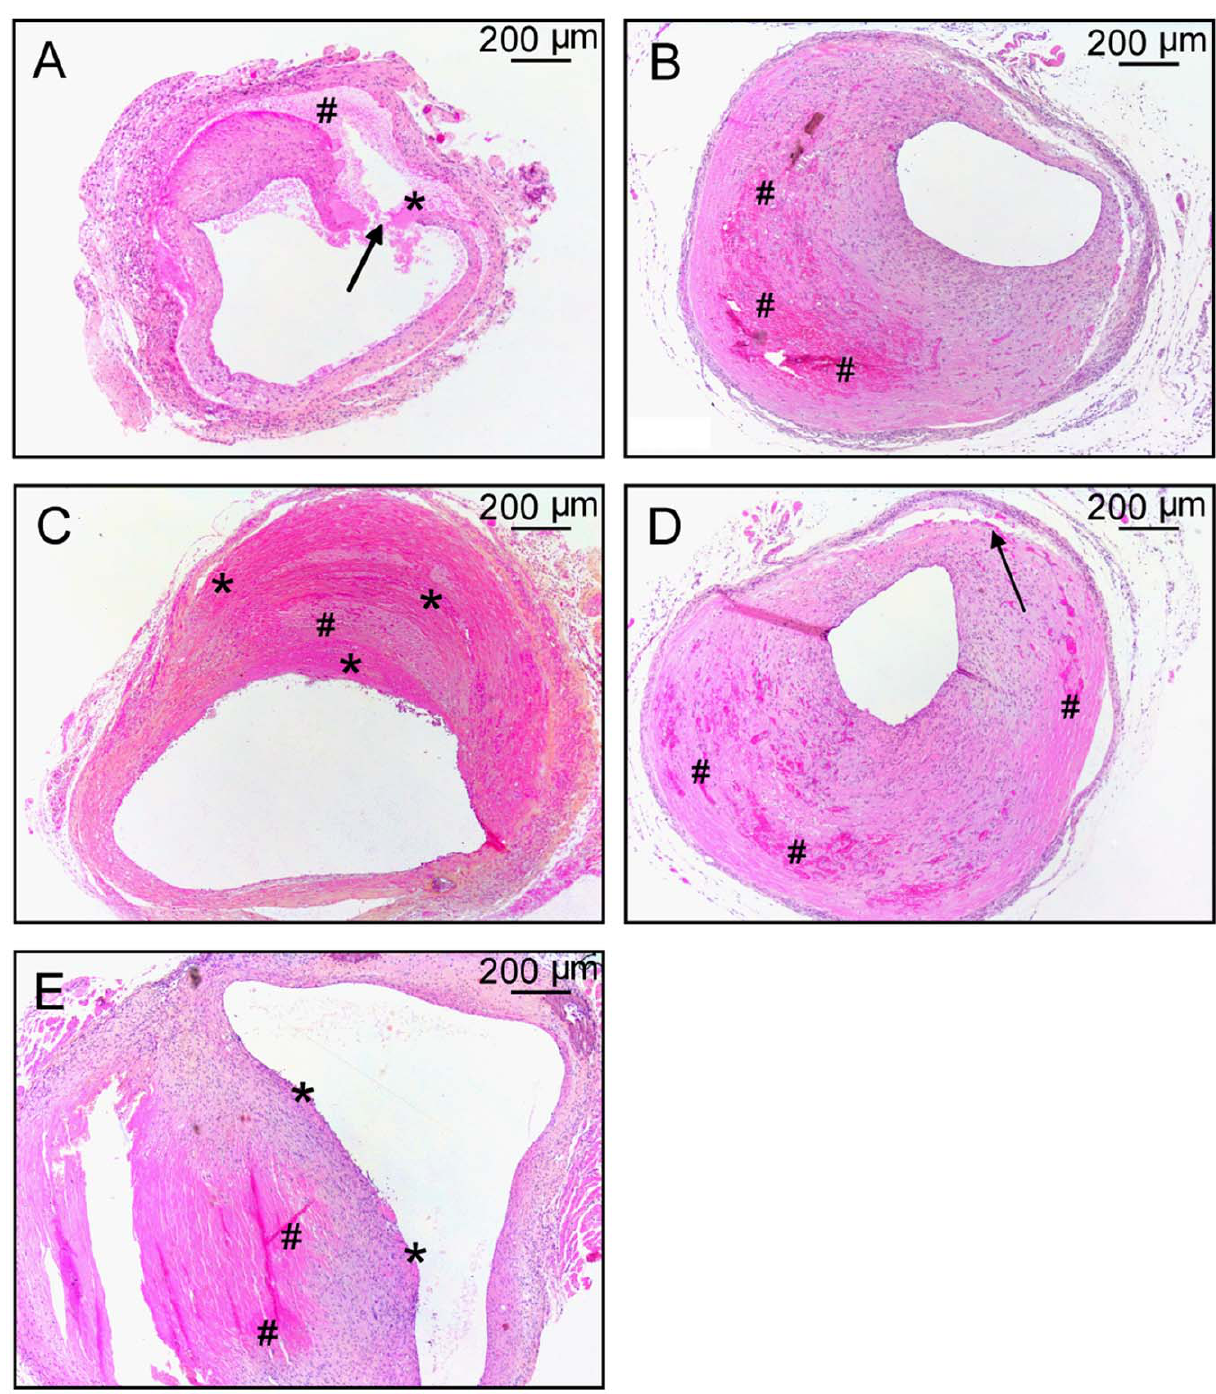
Figure 3. Divers forms of plaque rupture complications can be seen in vein graft lesions. A ; Vein graft with a dissection (arrow) starting at the lumen of the vessel wall with small fibrin depositions (*) and erythrocytes ( # ) in the clearly visible gap. B ; Vein graft lesion with leaky vessels and extravasated erythrocytes ( # ) C; Vein graft showing massive intramural thrombi consisting of layers of fibrin (*) and diffuse erythrocytes ( # ) with erosion extending to the outer part of the vessel wall D ; Vein graft showing combined leaky vessels with extravasated erythrocytes ( # ) and dissection in the outer part of the vessel wall (black arrow). E ; Vein graft lesion with leaky vessels showing extravasation of erythrocytes ( # ) and erosion with small mural thrombi (*).